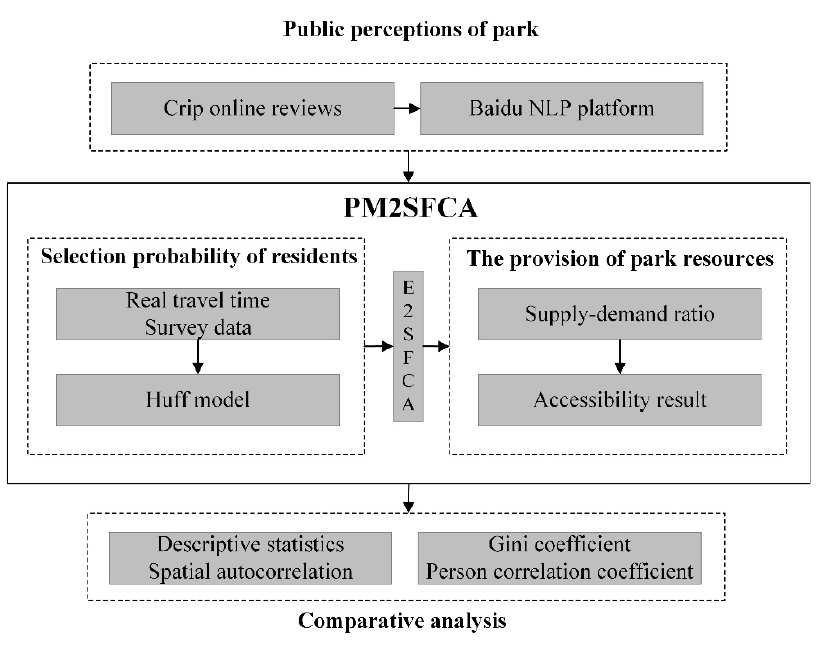
Figure 1. The framework of this research.